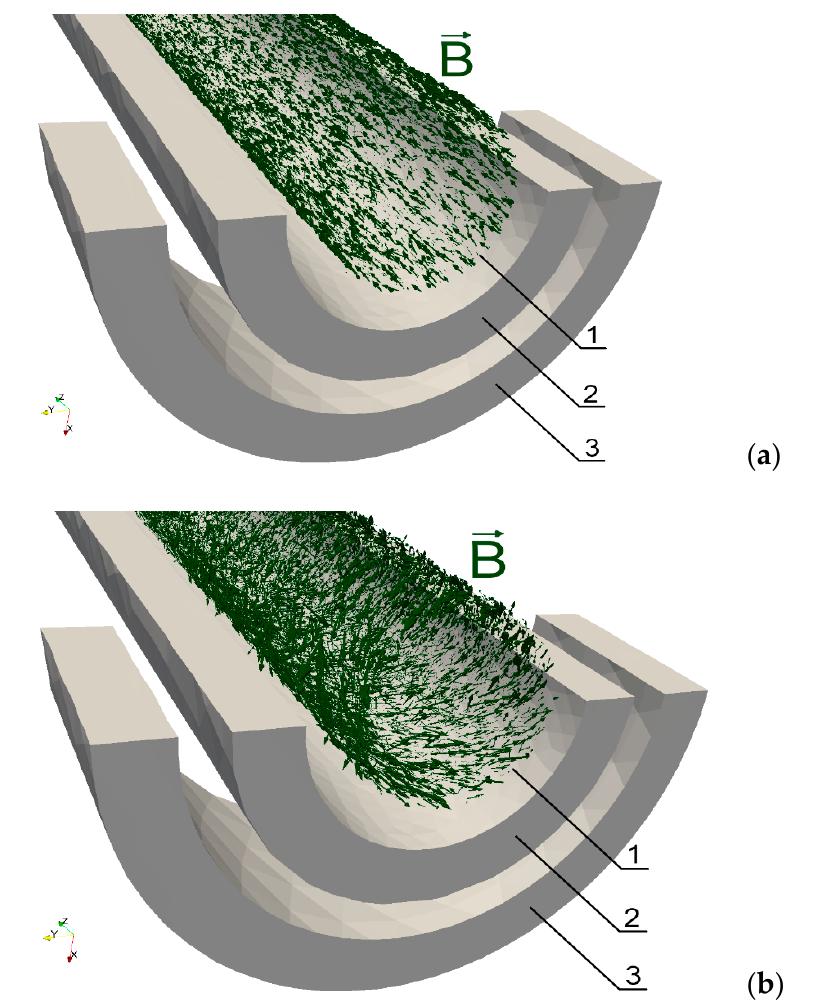
Figure 3. Magnetic field strength inside the shaft (first cross ‐ section along the shaft axis and the second perpendicularly to the shaft axis, through the center of the length of the shaft and the coils) for different values of torque M : ( a ) M = 0 Nm, ( b ) torque M = 1.3 Nm; 1—shaft (transparent), 2—magnetizing coil, 3—sensing coil.